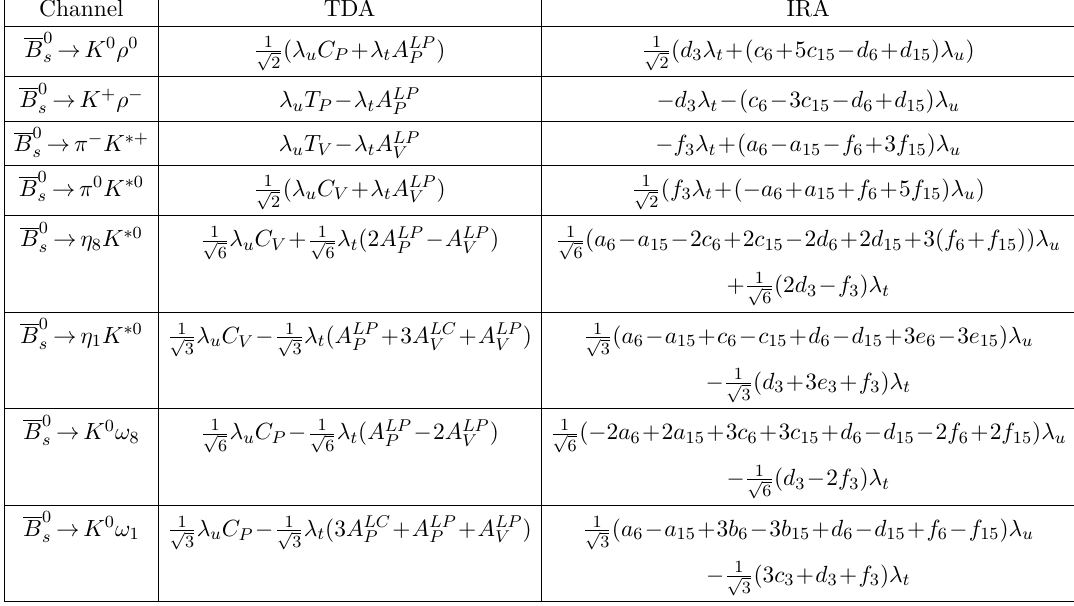
Table 9 . Decay amplitudes for the B s → PV decays induced by the b → d